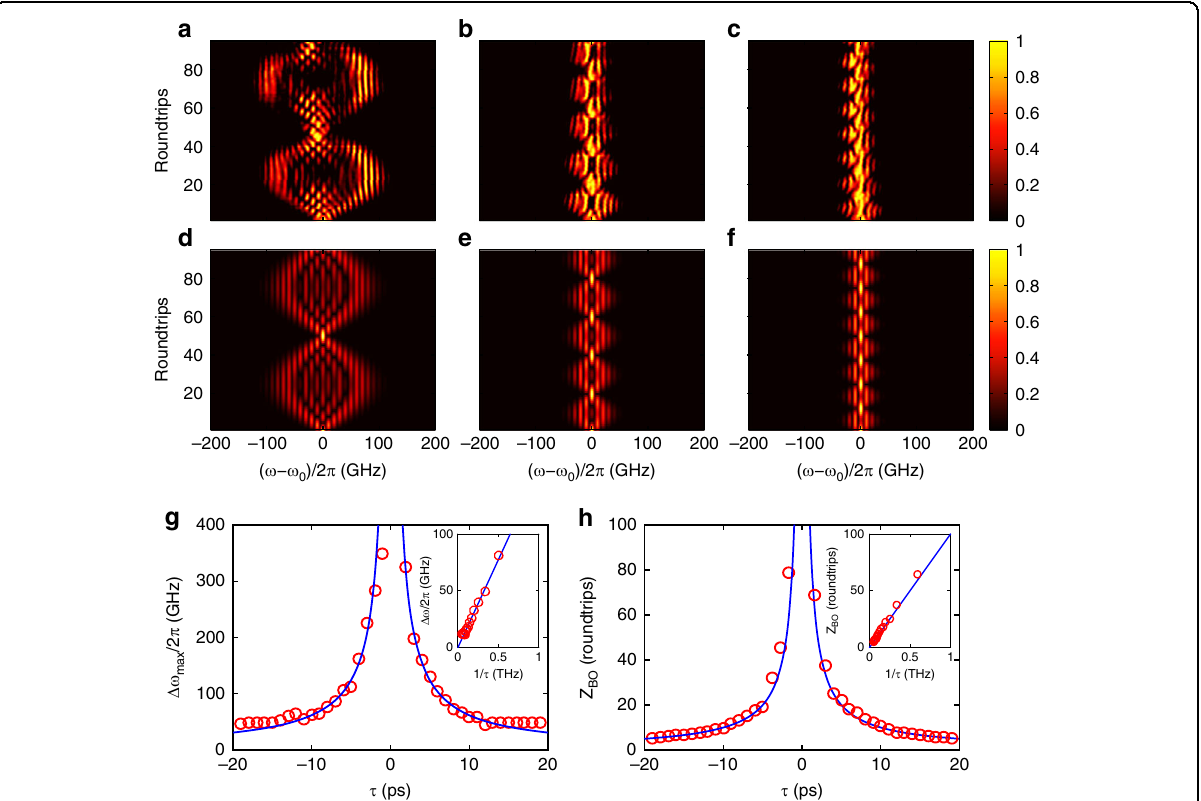
Fig. 4 Breathing patterns of the frequency BOs for the pulse duration T 0 = 140 ps. a – c Experimental spectrum evolution with τ = 2, 5 and 8 ps, respectively. The modulation depth is m φ = 0.45. d – f Numerical results corresponding to ( a – c ). g , h Dependence of the oscillation amplitude A BO and oscillation period Z BO on the time detuning τ . The red circles and blue lines represent the experimental and theoretical results, respectively. The insets in g and h show the experimental data of A BO and Z BO versus 1/| τ